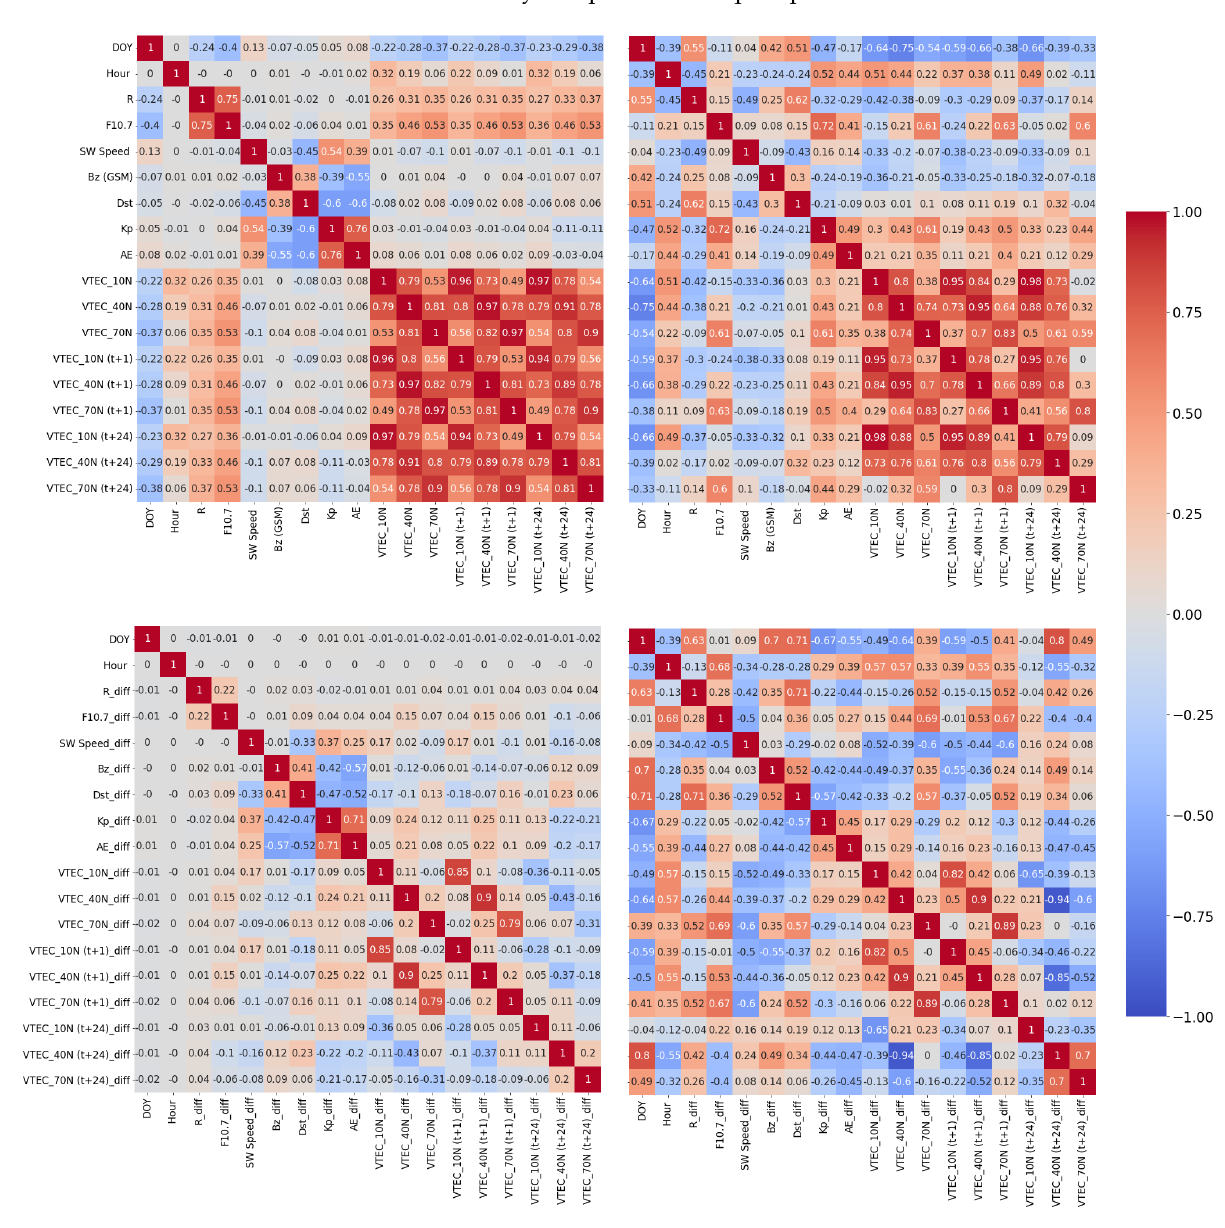
Figure 6. Correlation matrix between the model input and ground-truth VTEC. Top: non-differenced data, bottom: differenced data. left: training data (2015–2016), right: training data for Kp ≥